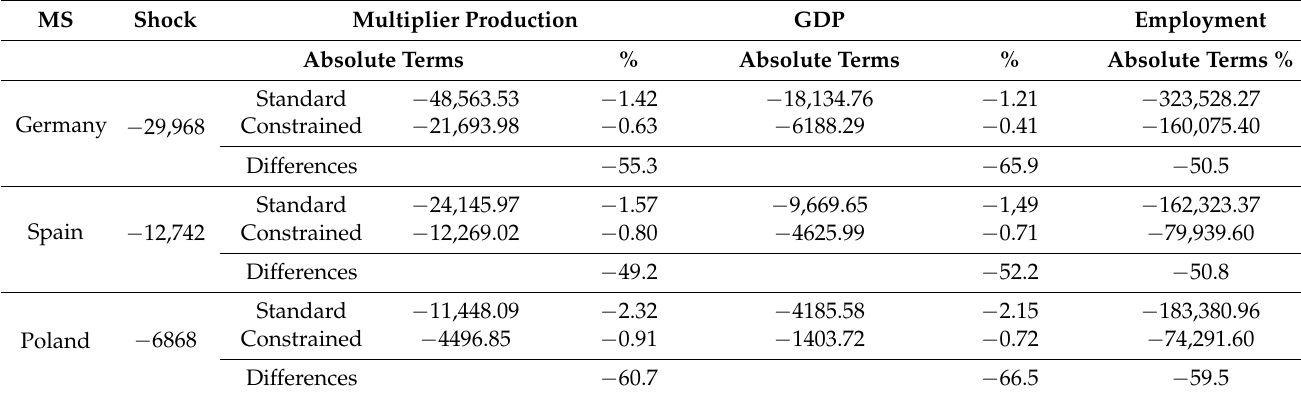
Table 1. Economic impact of FLW reduction along FSC (millions of euros, percentage, number of jobs). MS Shock Multiplier